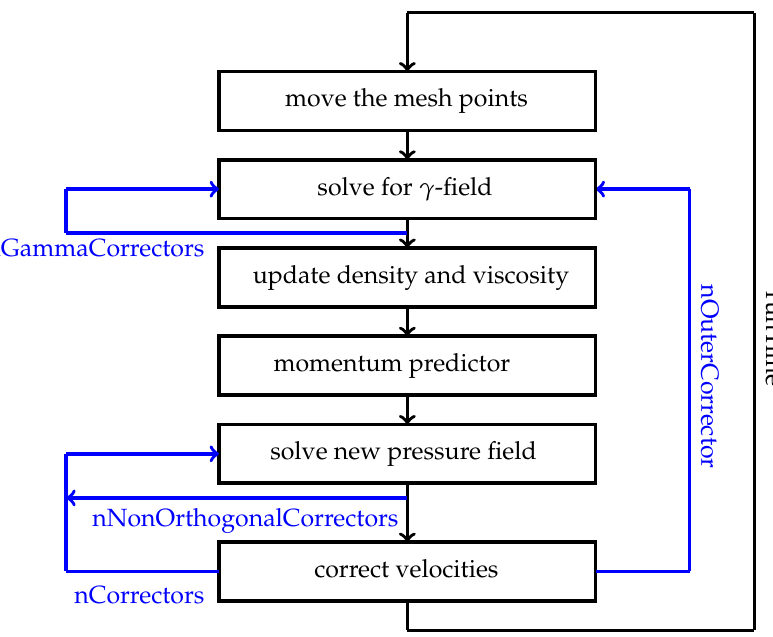
Figure 3. A schematic for the solution procedure of the two-phase